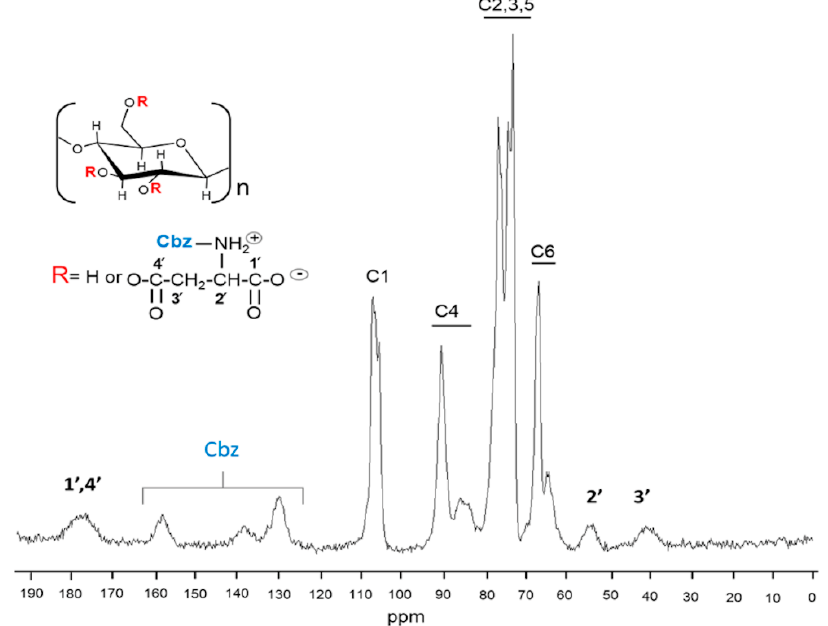
Figure 4. 13 C CPMAS NMR spectrum of cellulose modified with N-carbobenzyloxy-L-aspartic anhydride (Cel-Asp-N-Cbz).